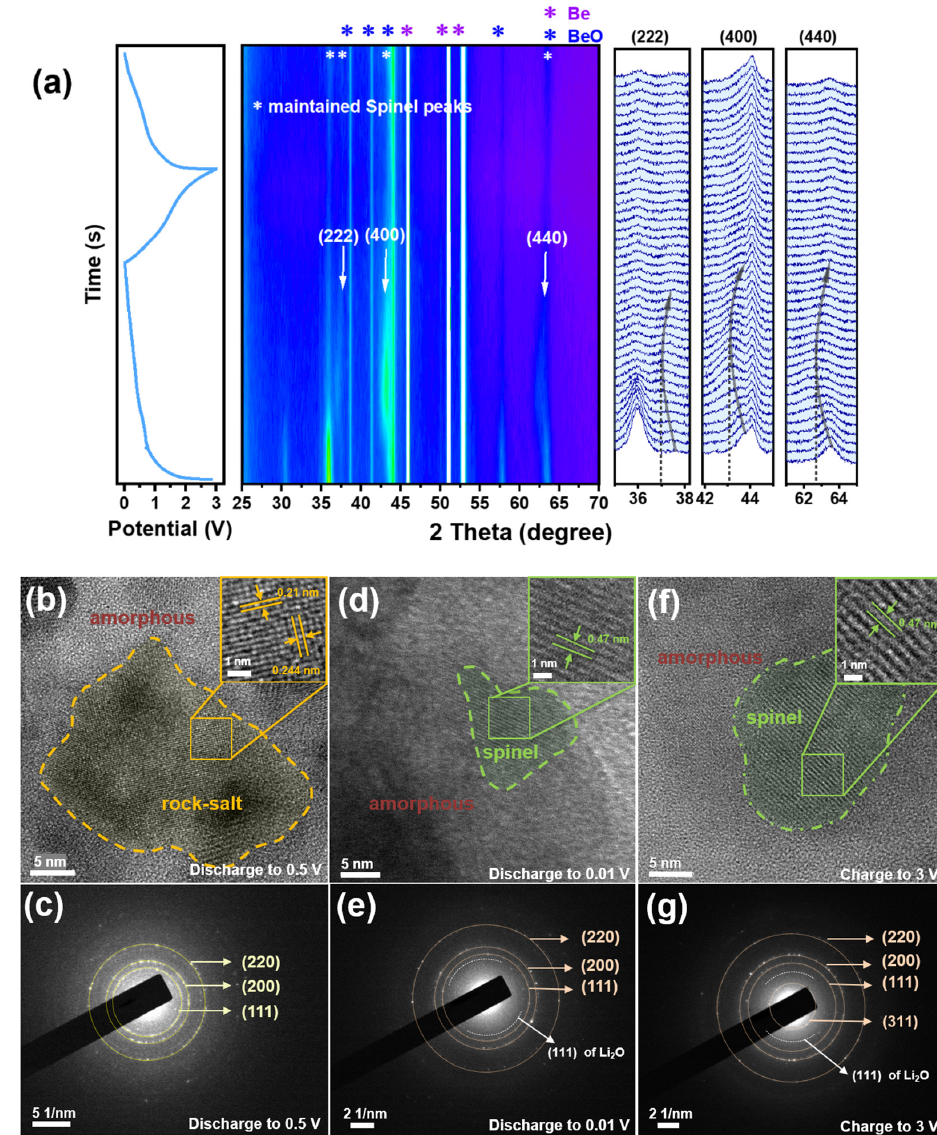
Figure 5. ( a ) In-situ XRD of the 6-SHEO anode recorded along the initial lithiation-delithiation and second delithiation process, ex-situ TEM and corresponded SEAD of the 6-SHEO while ( b , c ) first discharged to 0.5 V, ( d , e ) first discharged to 0.01 V, and ( f , g ) first charged to 3